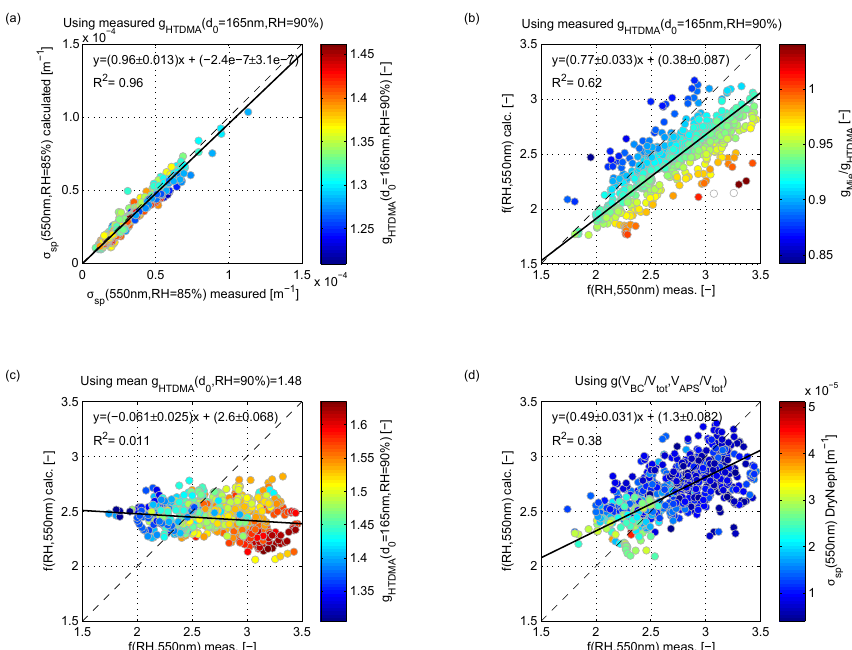
Fig. 5. Panel (a) Scattering coefficient σ sp calculated vs. measured using the hygroscopic growth factor measured by the H-TDMA. Panel (b) – (d) Scattering enhancement factor f (RH=85%, 550nm) calculated vs. measured values. Panel (b) The measured hygroscopic growth factor of the H-TDMA (dry diameter d 0 = 165nm) has been used for the calculation, the color code denotes the ratio of g Mie /g HTDMA . Panel (c) A fixed value of g (d 0 RH = 90% ) = 1 . 48 (mean for that period) has been used for the calculation. Panel (d) An empirical relation of g(V BC /V tot ,V APS /V tot ) has been used for the calculation of f (RH). All values are shown at RH=85%. The solid black line represents a bivariate linear regression including weights (with calculated uncertainty of slope and intercept). The 1:1-line is shown as a dashed